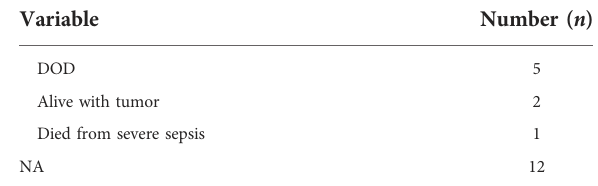
TABLE 1 Patient demographics and tumor characteristics of extrapancreatic solid pseudopapillary